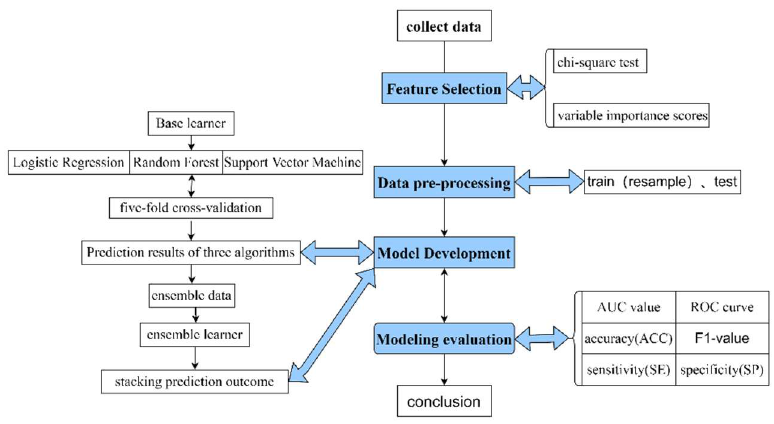
Figure 2. The experimental flow of the research method.